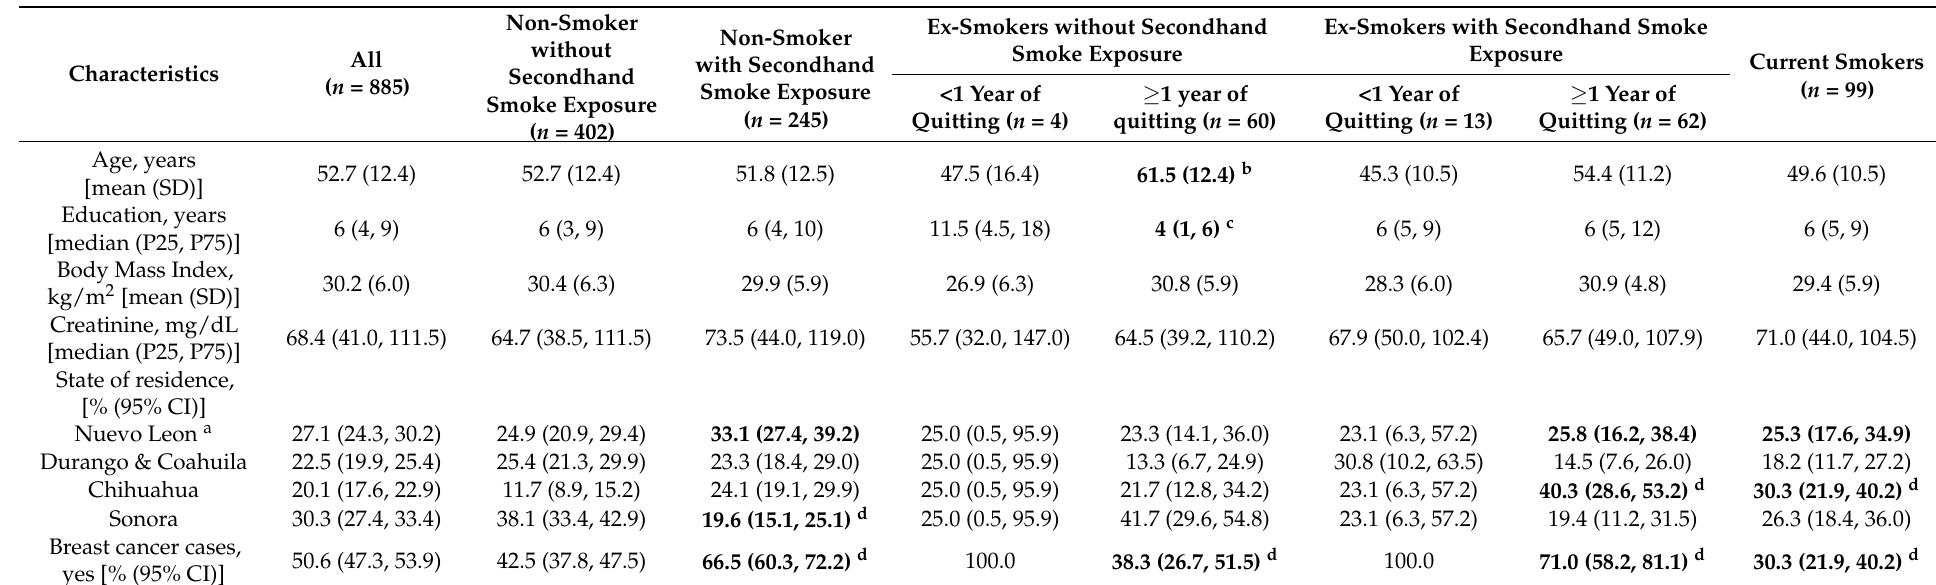
Table 1. Characteristics of study participants according to self-reported smoke